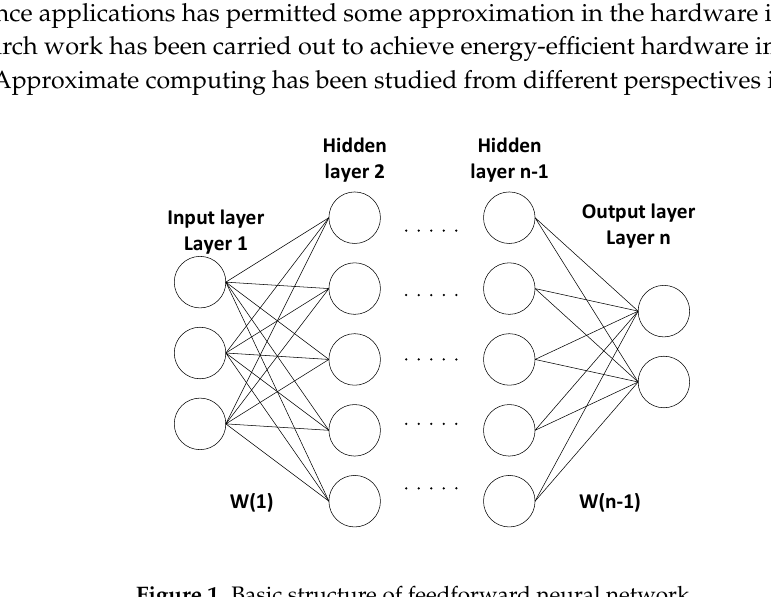
Figure 1. Basic structure of feedforward neural